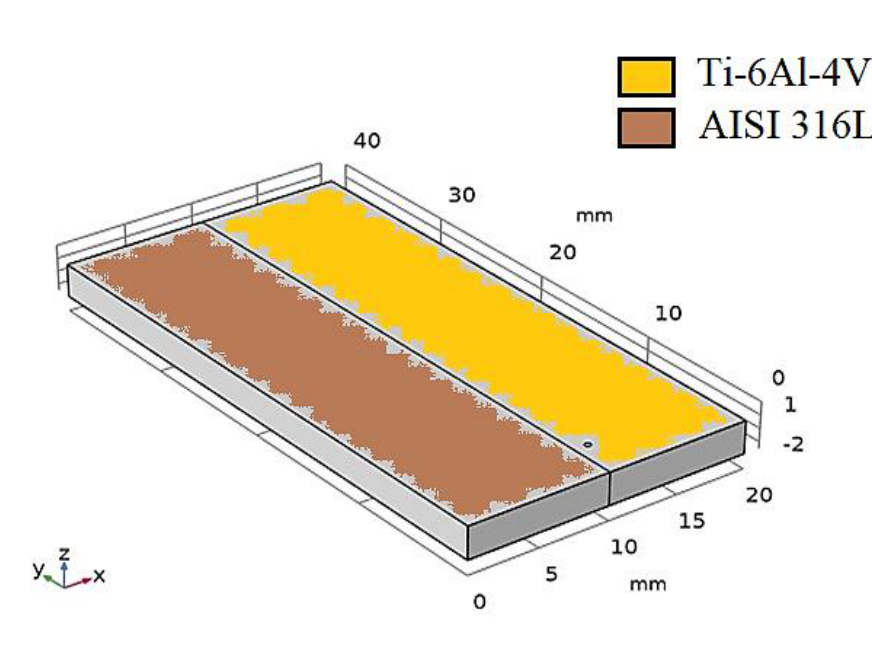
Figure 1. Geometry of the model.